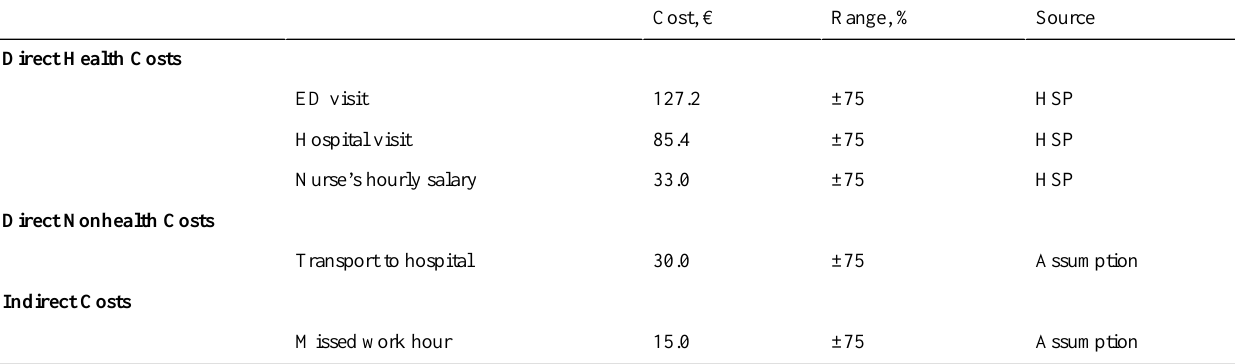
Table 1. Direct and indirect costs included in the analysis (cost sources and ranges considered in the study are